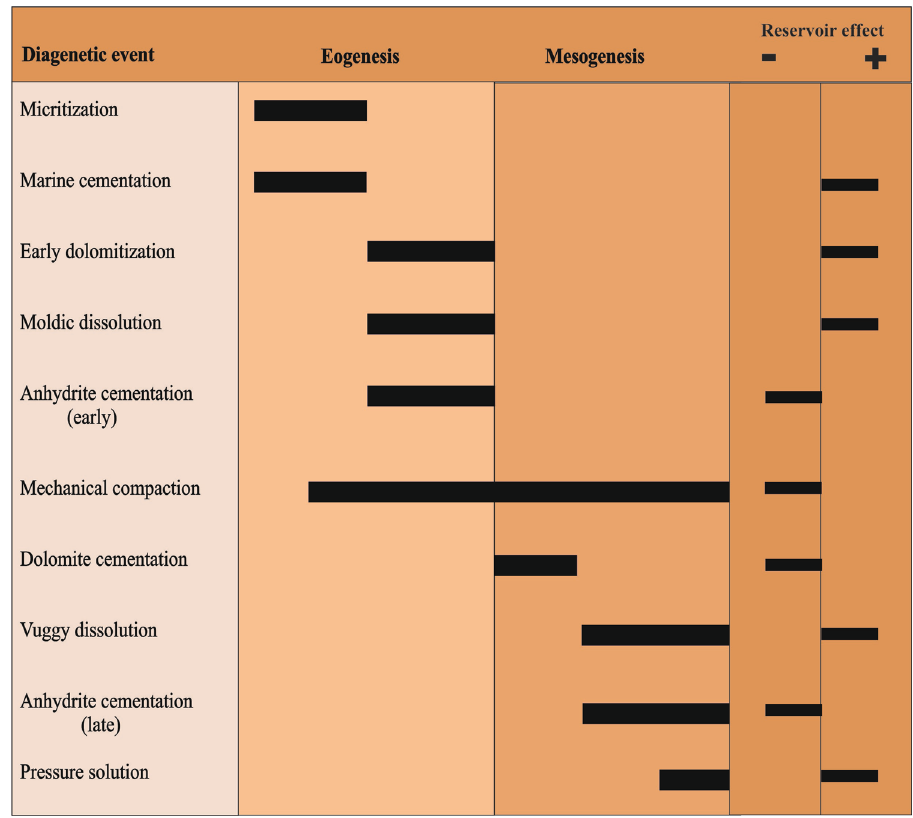
Fig. 5 The paragenetic sequence of diagenetic events of the Arab Formation. This diagram reveals diagenetic processes occurred in eogenetic and mesogenetic envi- ronments. Moreover, the effect of each diagenetic processes on reservoir quality is